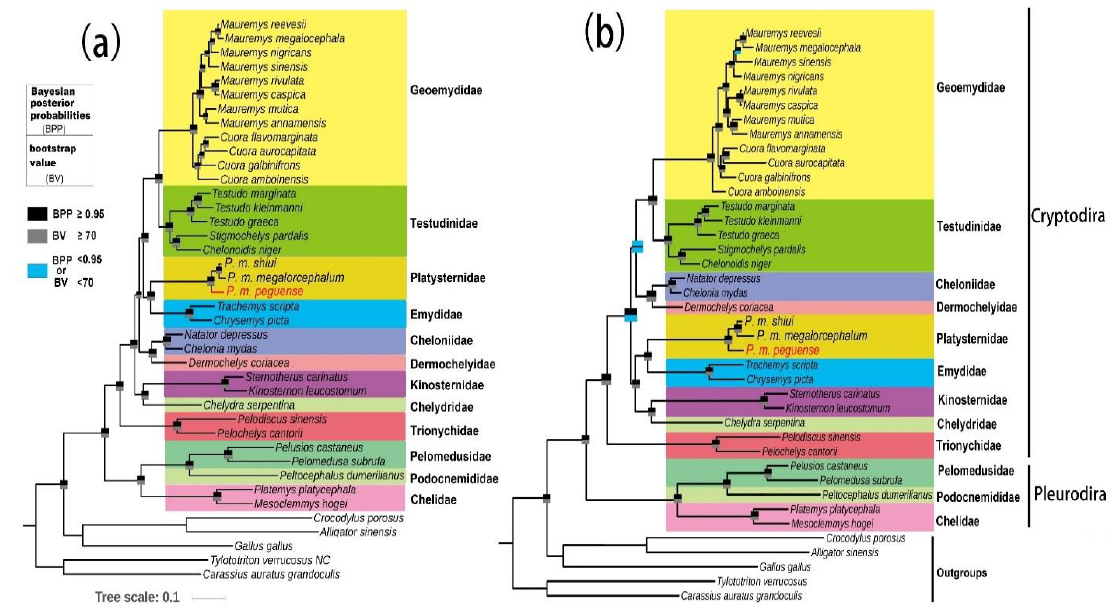
Figure 5. Phylogenetic tree of Platysternon and turtles based on the concatenated ( a ) nucleotide and ( b ) amino acid sequences of 13 PCGs both using maximum likelihood (ML) and Bayesian inference (BI) analysis. At each node, the upper rectangle indicates the Bayesian posterior probability (BPP), used for the Mrbayes analyses, while the lower rectangle bootstrap value (BV) was used for the RaxML analyses. Species specific taxonomic ranks were incorporated with specific clades.